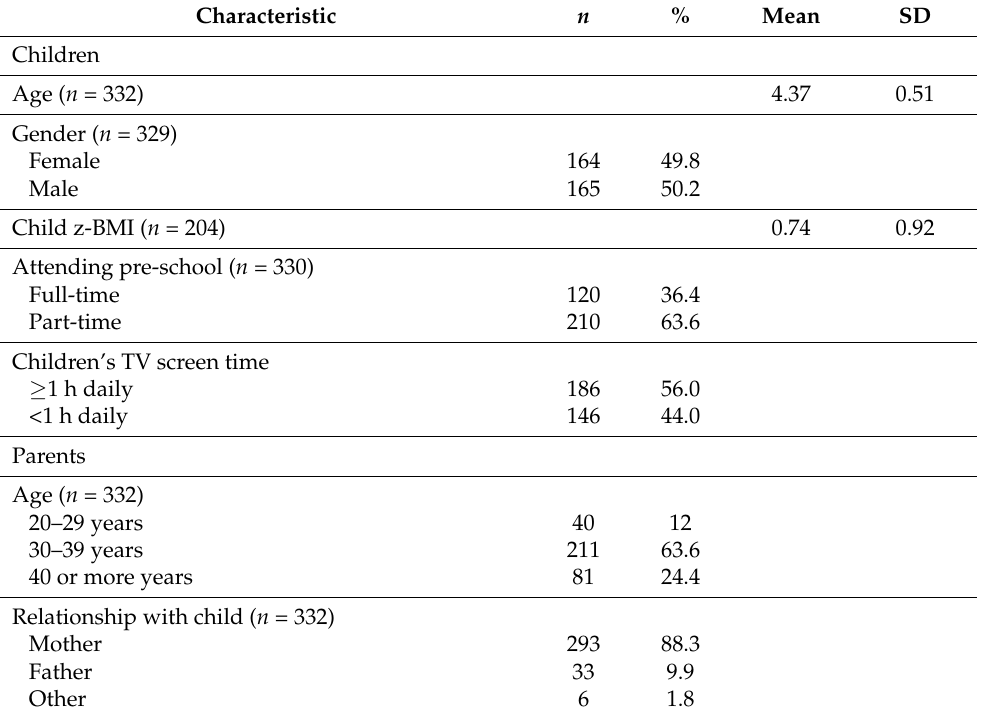
Table 1. Characteristics of